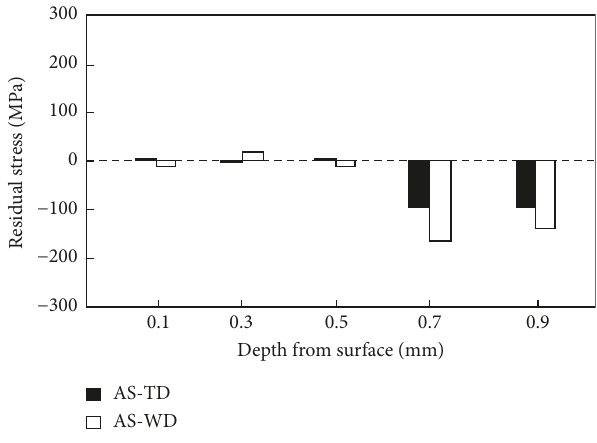
Figure 6: Residual stress distribution of the advancing side.